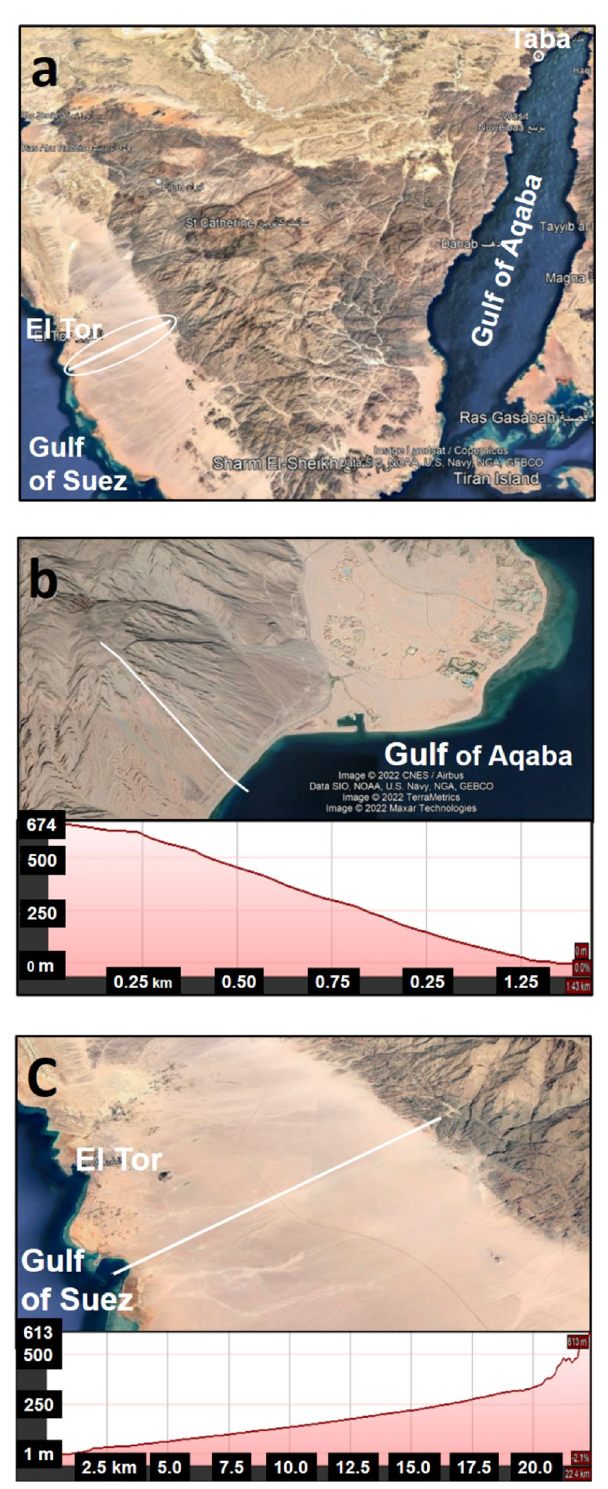
Fig. 3 ( a ) Google Earth map of part of the South Sinai with two loca- tions considered for gravity-driven distributed RO shown in ( b ), and gravity-assisted distributed RO shown in ( c ). The elevation plots of the two locations are